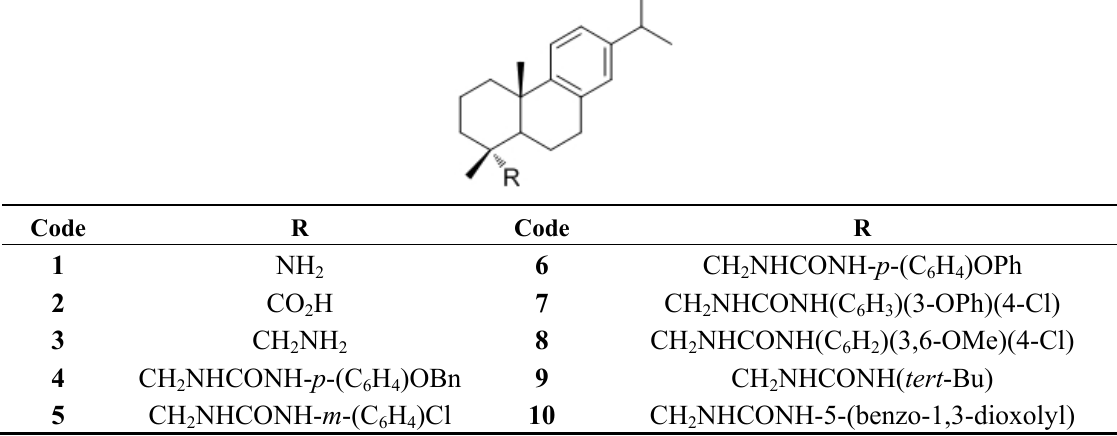
Table 1. Chemical structures of the abietane-type diterpenes studied in this contribution.